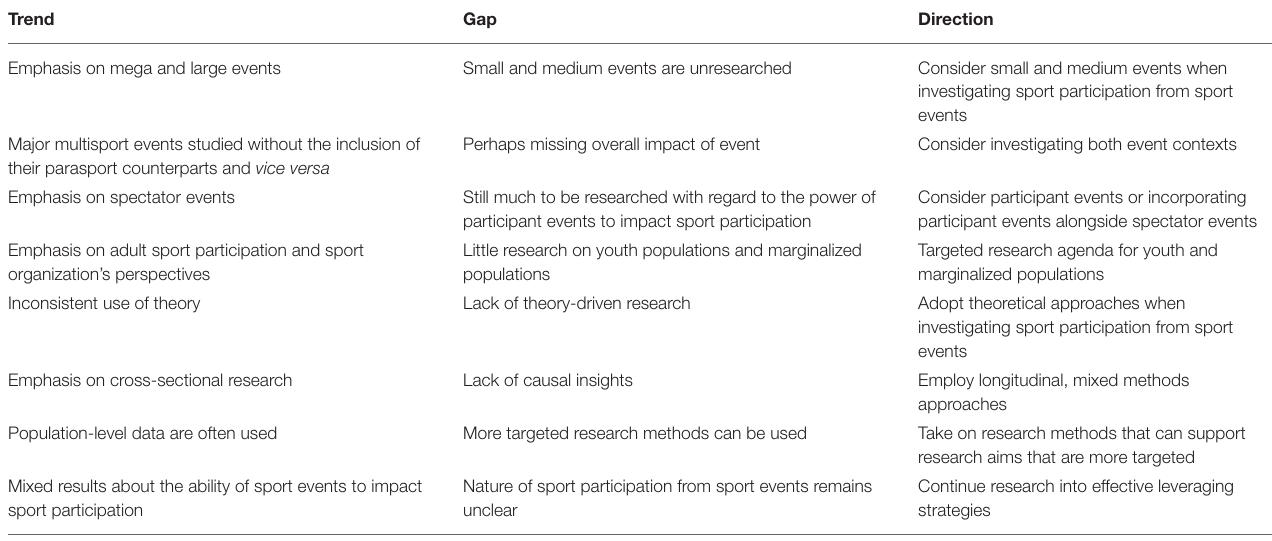
TABLE 3 | Summary of key findings.